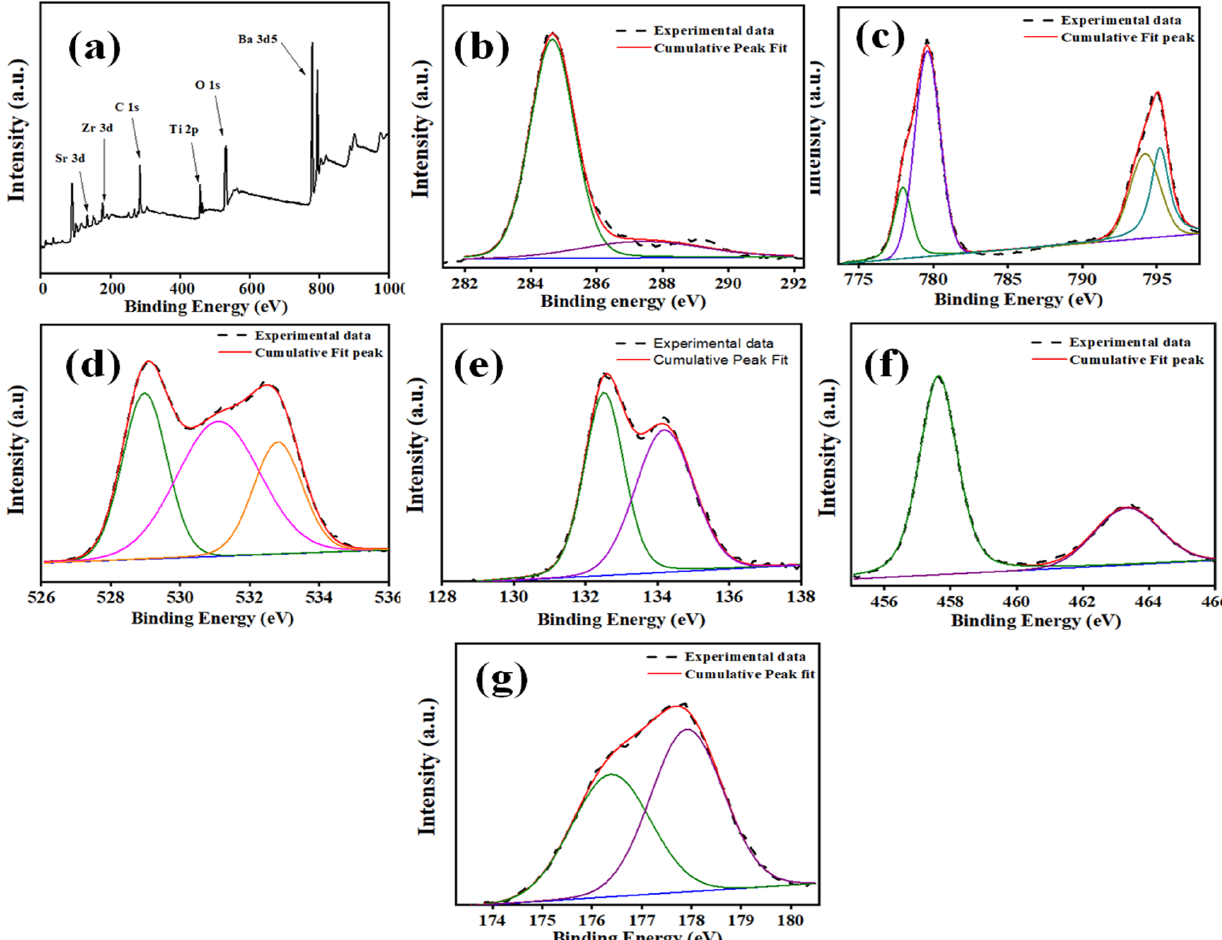
Figure 5. ( a ) XPS survey showing elemental composition in BST ‒ BZT, ( b ) C1s spectrum, ( c ) Ba 3d spectrum, ( d ) O1s spectrum, ( e ) Sr3d spectrum, ( f ) Ti2p spectrum, ( g ) Zr 3d spectrum.